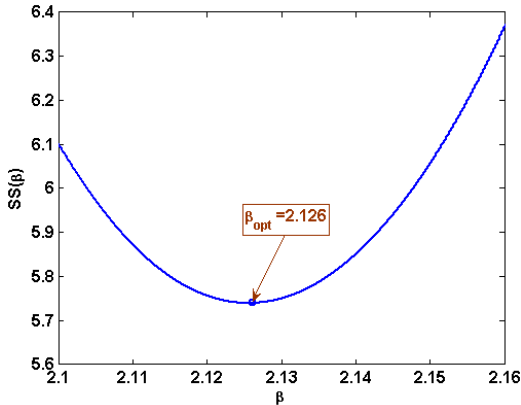
Figure 7. Graphical method for determining the shape parameter